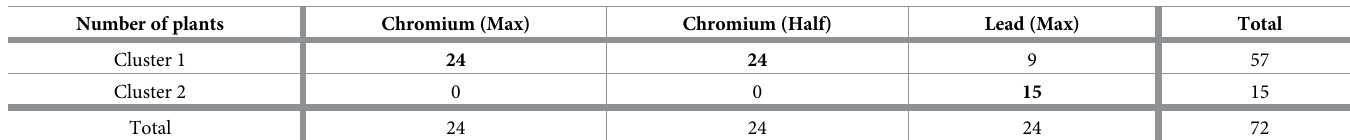
Table 5. Results of the cluster analysis reported in Section 3.4.1. Number of plants